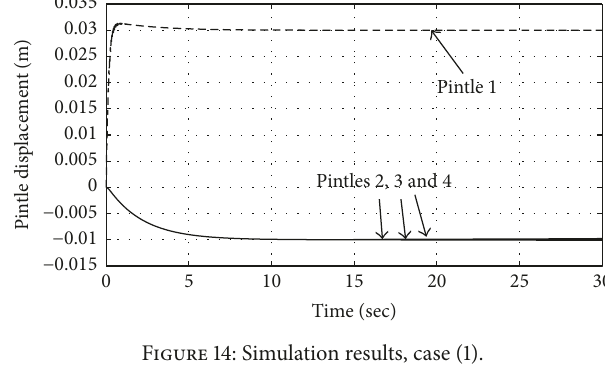
Figure 14: Simulation results, case (1).